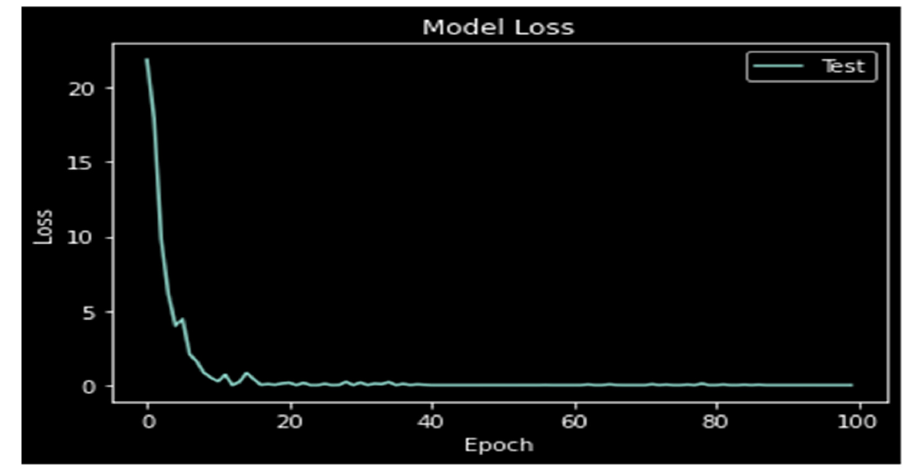
Figure 9. Model Loss.